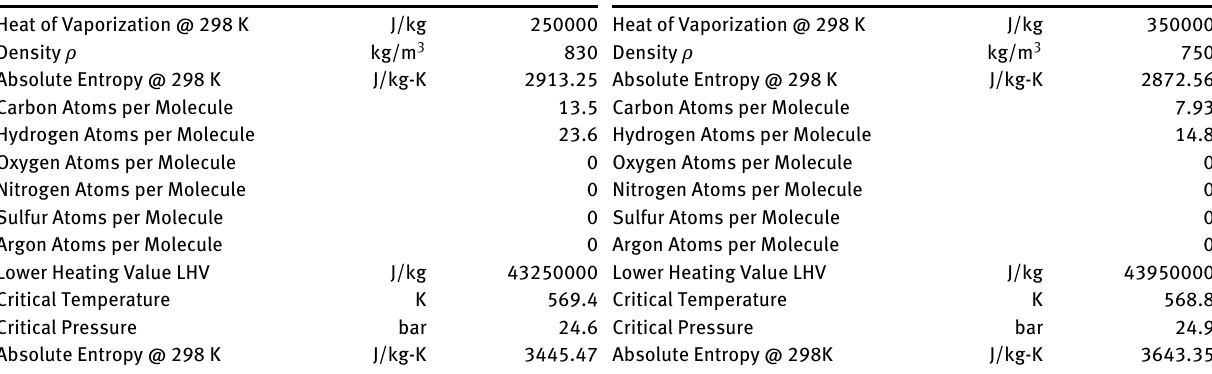
Table 5: Properties C 13.5 H 23.6 Table 6: Properties of C 7.93 H